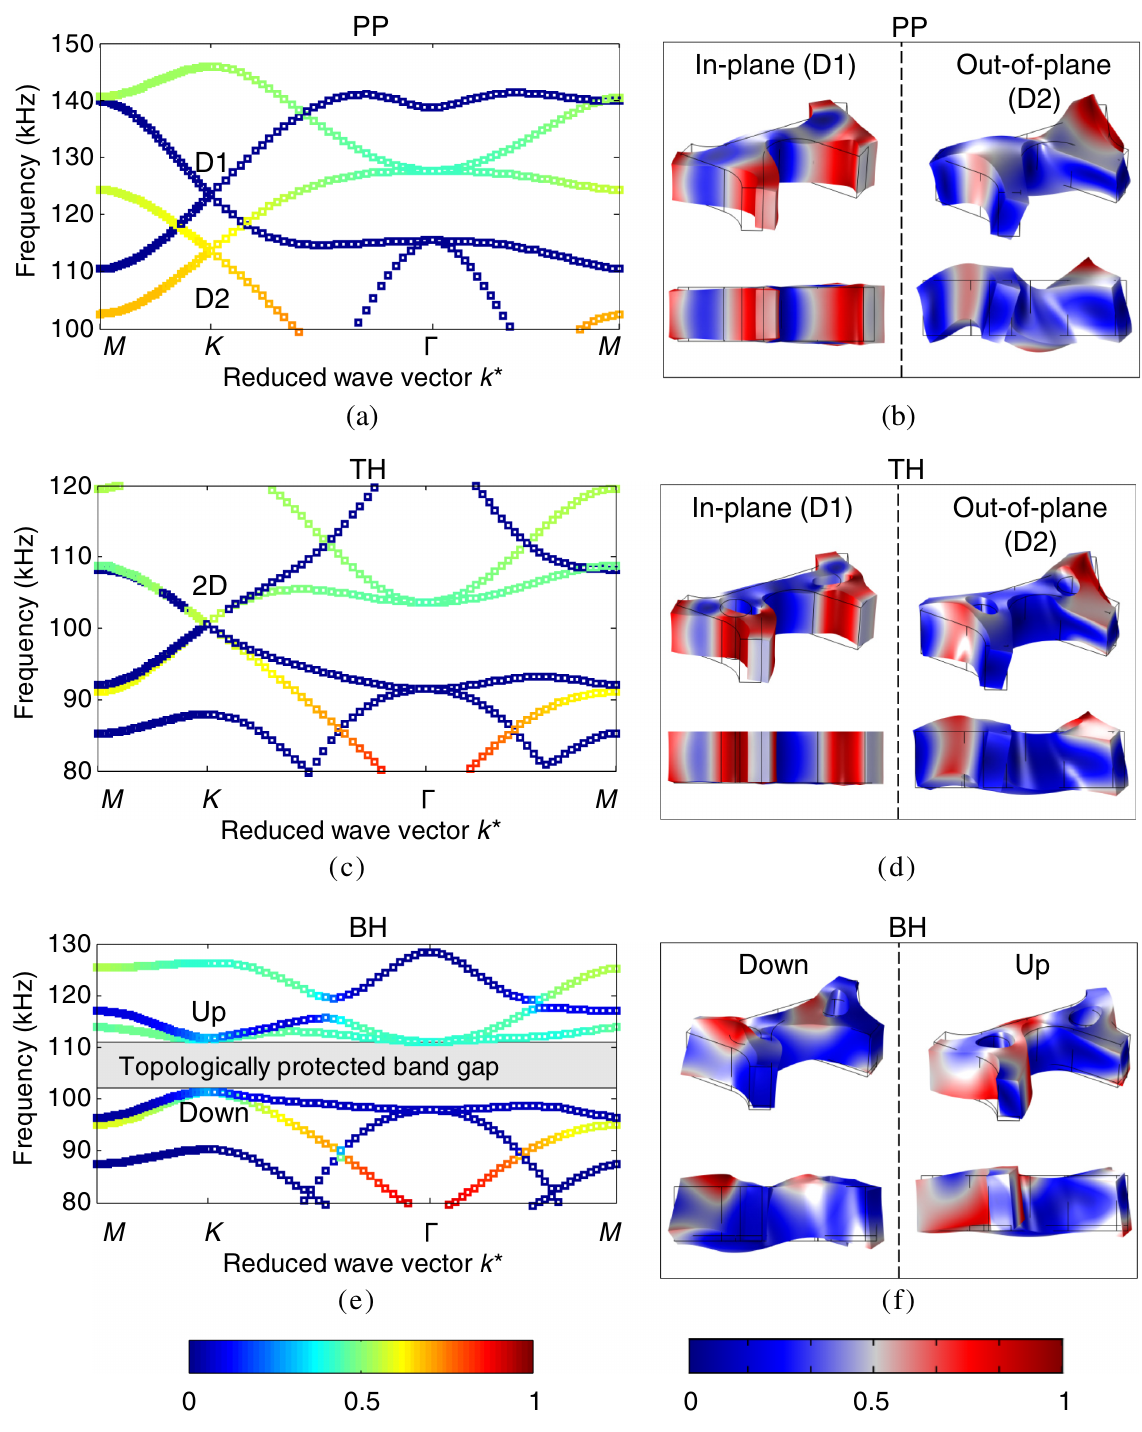
FIG. 2. Selective dispersion curve manipulation for the double Dirac cone nucleation and breaking of the σ h mirror symmetry for the opening of a topologically nontrivial band gap. (a) Band structures for the PP exhibiting two separate Dirac points D1 and D2 at the K point. Different mode polarizations are indicated by colors, ranging from pure in-plane (blue) to pure out-of-plane (red) [the same metric applies to Figs. 2(c) and 2(e)]. (b) Wave modes D1 and D2 at the K point for the PP configuration characterized by dissimilar polarizations. The colors denote the normalized displacement [the same metric applies to Figs. 2(d) and 2(f)]. (c) Band structures for the plate with additional TH showing the double degenerate Dirac point 2D. (d) Wave modes D1 and D2 at the K point for the TH configuration, which preserves the σ h symmetry without the occurrence of mode coupling. (e) Band structures for the plate with BH characterized by the nucleation of a topological band gap of 9.7% relative width. (f) Coupling of the D1 and D2 modes responsible for the opening of the topological band